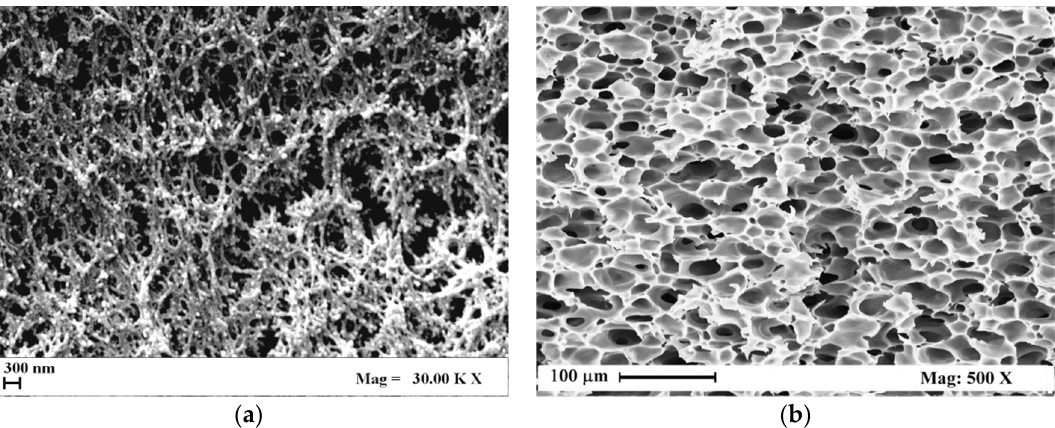
Figure 2. FE-SEM pictures of samples internal section: ( a ) A/G 50/50% v / v aerogel and ( b ) CA/GO 9% w / w membrane.